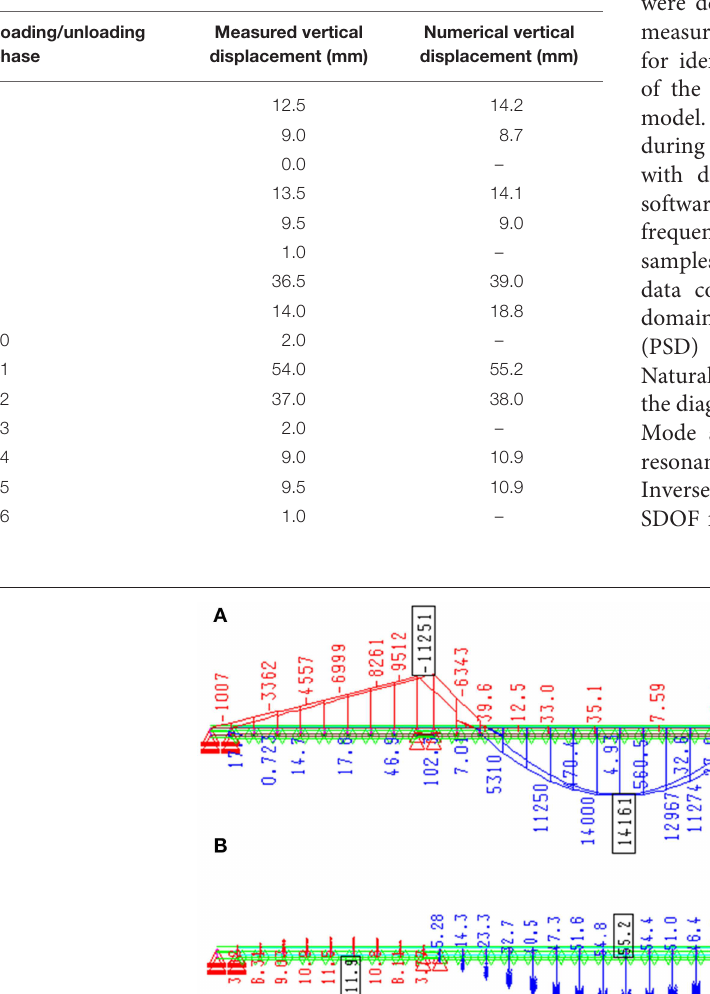
TABLE 1 | The comparison between maximum measured and numerical vertical displacement.